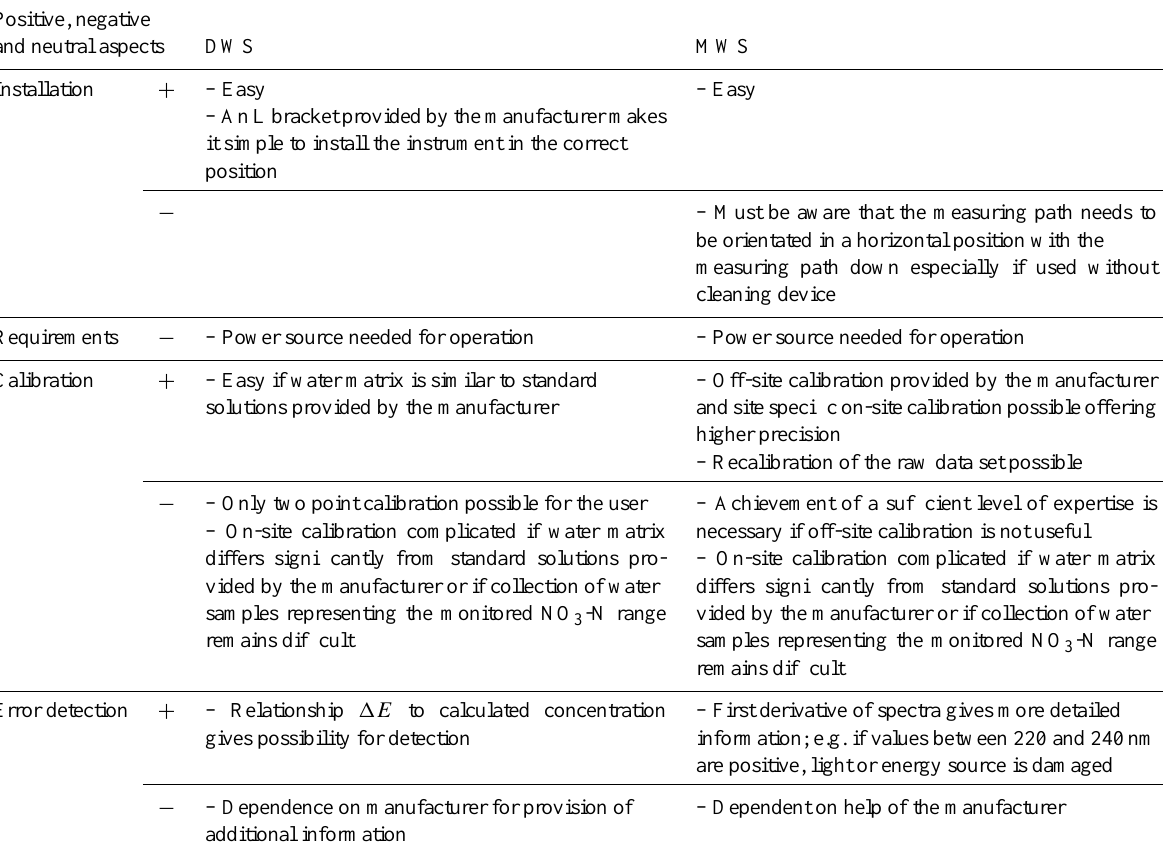
Table 2. Evaluation of applying the DWS and the MWS: positive ( + ), negative ( − ) and neutral (o) aspects. Positive,